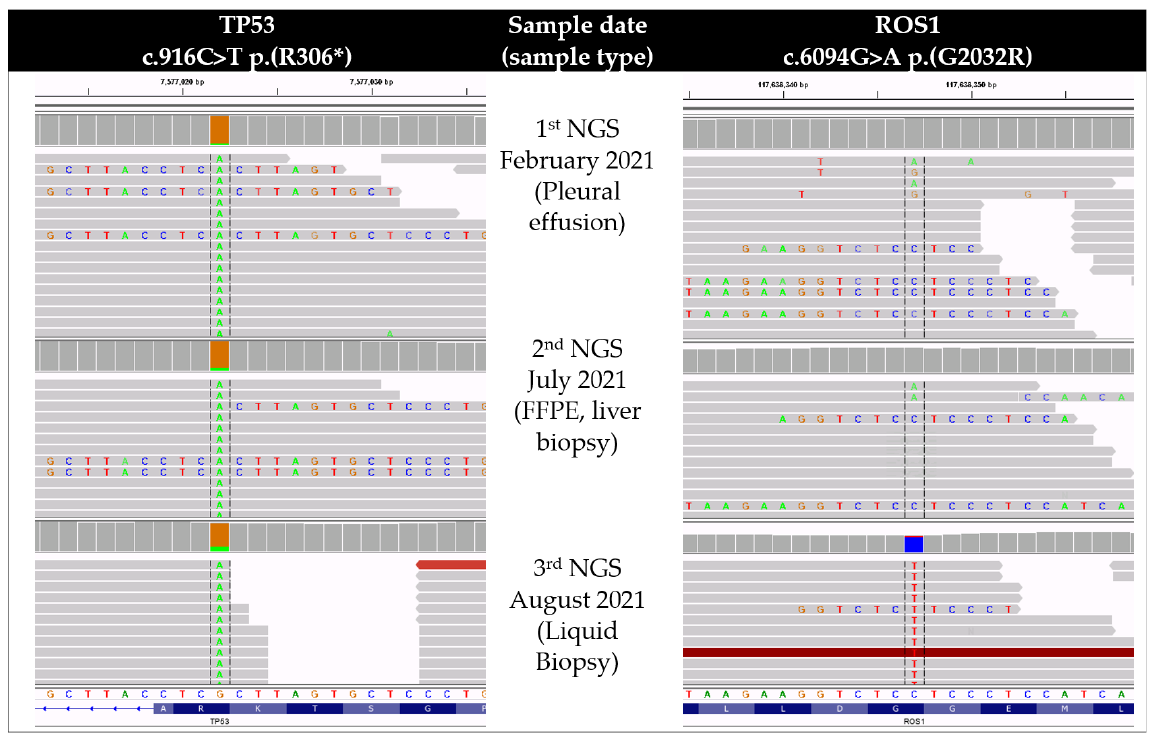
Figure 2. Single nucleotide variants detected with NGS during resistance development. Initial diagnosis detected NM_001126112.2: c.916C > T (p.(R306 *)) mutation in TP53 with a variant allelic frequency (VAF) of 6% at a tumor cell content (TCC) of 70%. It has been confirmed in the second biopsy from the liver 4 months later (TP53 VAF: 12% at TCC: 30%). Neither 1st, nor 2nd NGS showed the presence of a G2032R resistance mutation in ROS1. Five months after the initial diagnosis, liquid biopsy confirmed TP53 mutation (VAF: 19%) and revealed the NM_002944.2: c.6094G > A (p.(G2032R)) resistance mutation (VAF: 11%) in